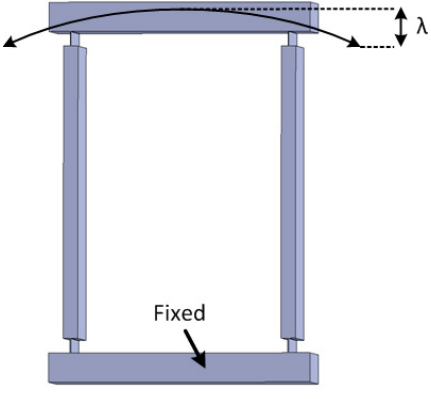
Figure 6. Sketch of the 4-prismatic hinge table trajectory.